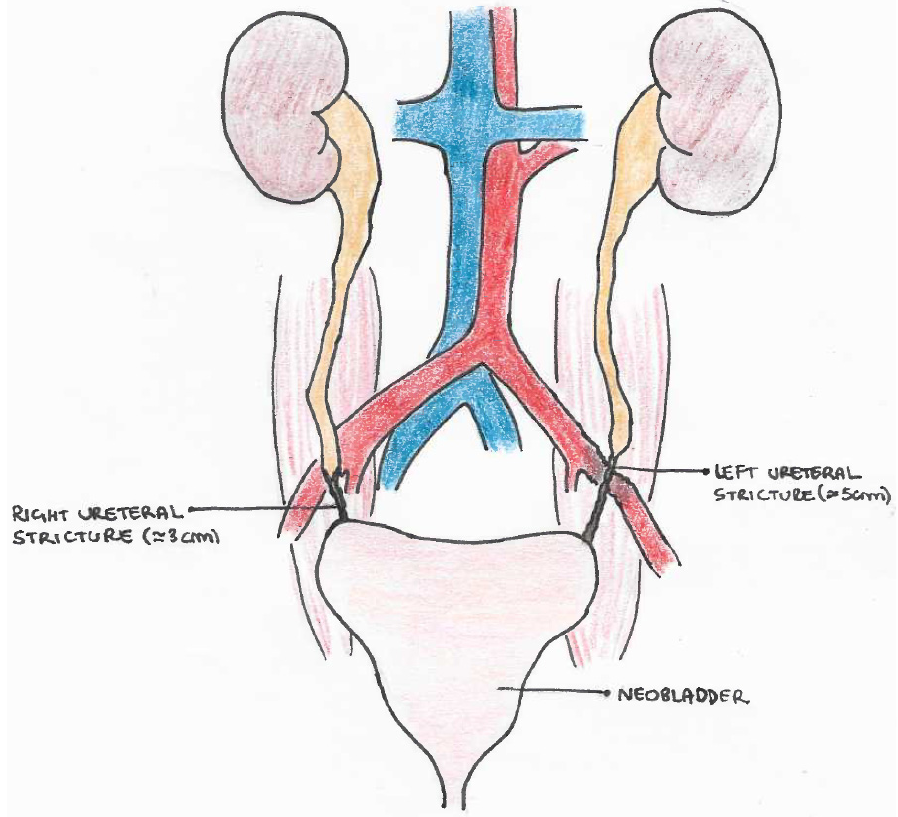
Figure 2. Drawing of bilateral UES in intracorporeal neobladder (VIP), with involvement of left external iliac artery in the scarring process.